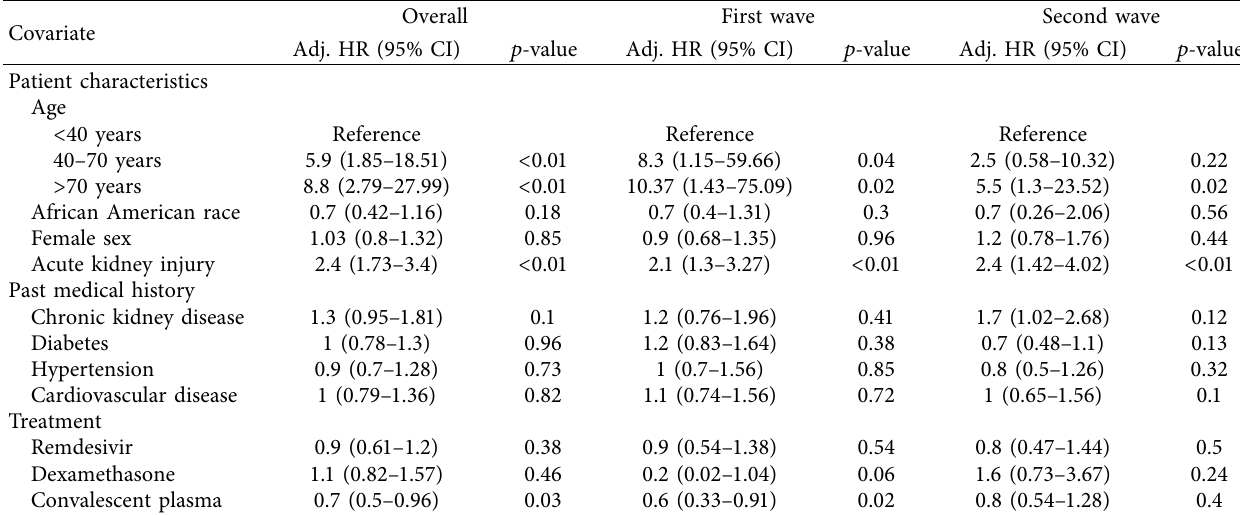
Table 2: Comparison of risk factors for mortality.